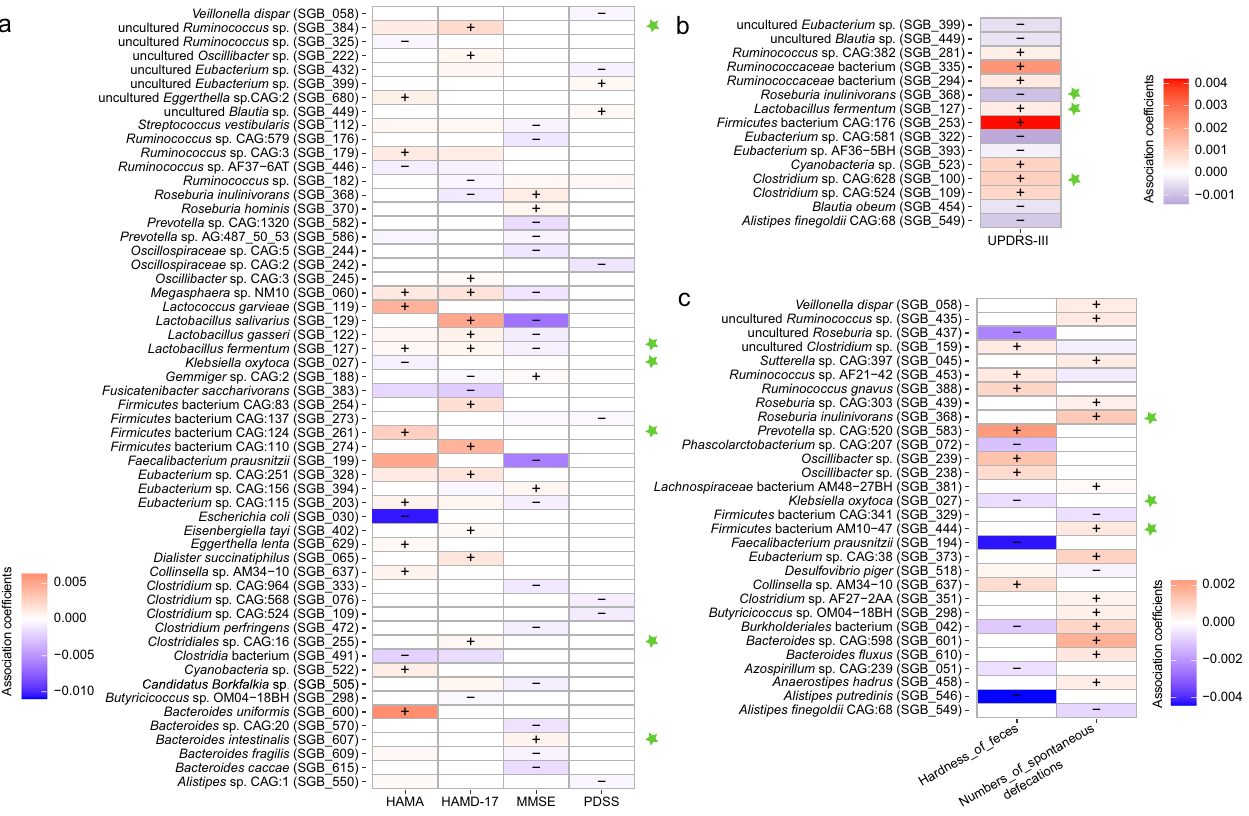
Fig. 3 Association between fecal species-level genome bins (SGBs) of patients with Parkinson ’ s disease (PD) and clinical indicators of Parksoion-associated symptoms. Association between gut microbiota and a mental state (represented by Hamilton Anxiety Scale, Hamilton Depression Scale-17, and Mini-mental State Examination) and sleep quality (represented by PDSS) of patients, b patient ’ s disease progression (Uni fi ed Parkinson Disease Rating Scale-III), and c constipation-related symptoms (feces hardness and numbers of spontaneous defecation). Marker SGBs for PD were marked by a green star. “ + ” and “ − ” represent a positive and negative association,